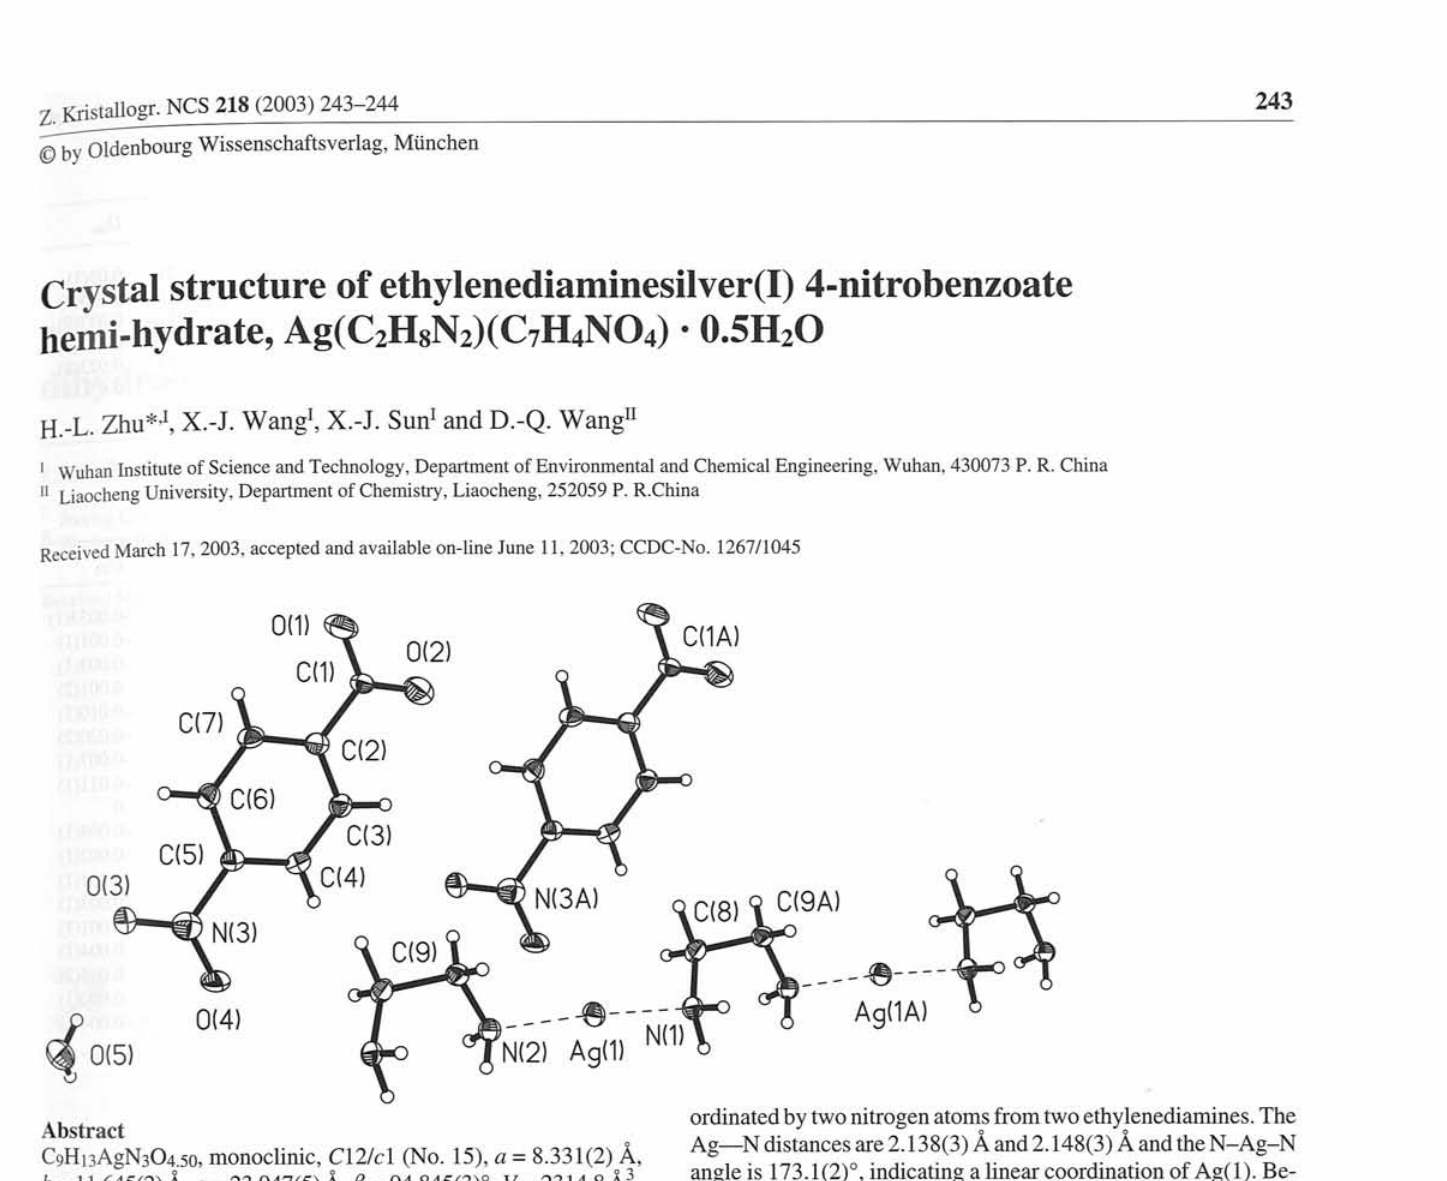
Table 1. Data collection and handling.